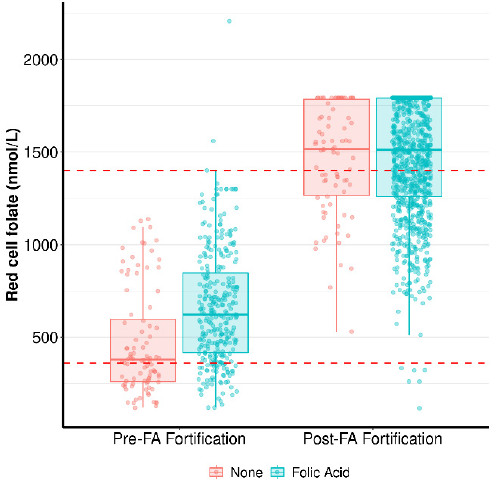
Figure 3. Red cell folate concentration in pregnant women prior to and post-FA food fortification: Data in the pre- and post-FA fortification categories are presented as medians (IQ range) and divided into two groups: women who did not take FA supplements (None, in red) and women who took FA supplements in the first trimester of pregnancy (Folic Acid, in green). The RCPA RCF reference range (360–1400 nmol/L) is represented by red dotted lines. The assay’s upper limit of detection is 1790 nmol/L. Measures of red cell folate were compared between STOP (N = 711) and a separate pre-FA fortification cohort (not SCOPE, N = 410) using the Mann–Whitney U test.